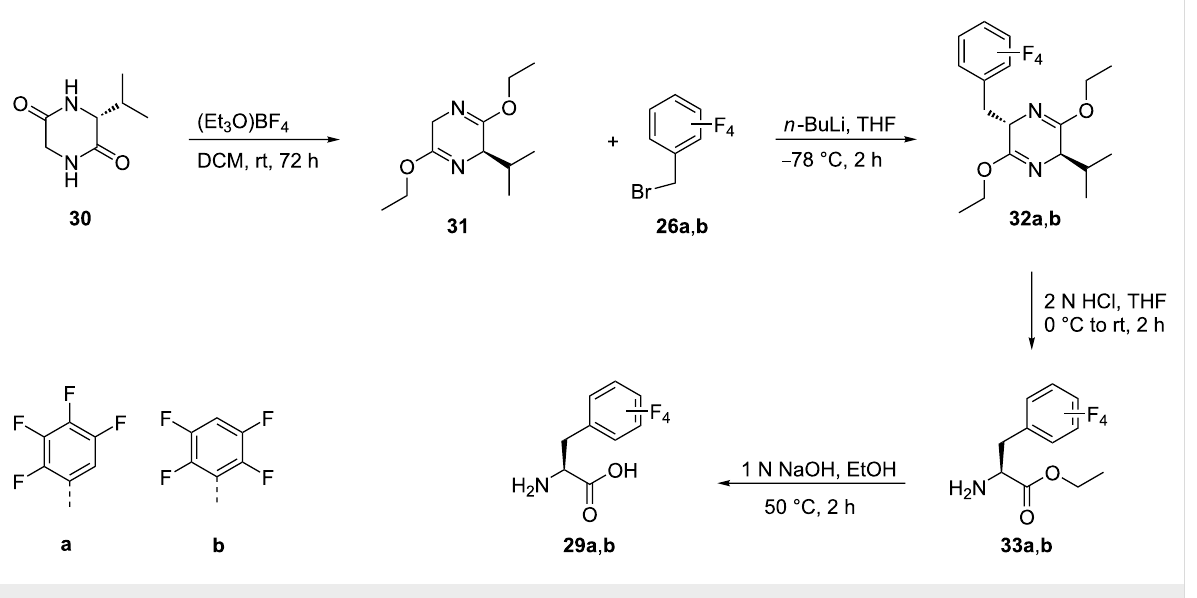
Scheme 7: Synthesis of tetrafluoro-Phe derivatives via chiral auxiliary 31